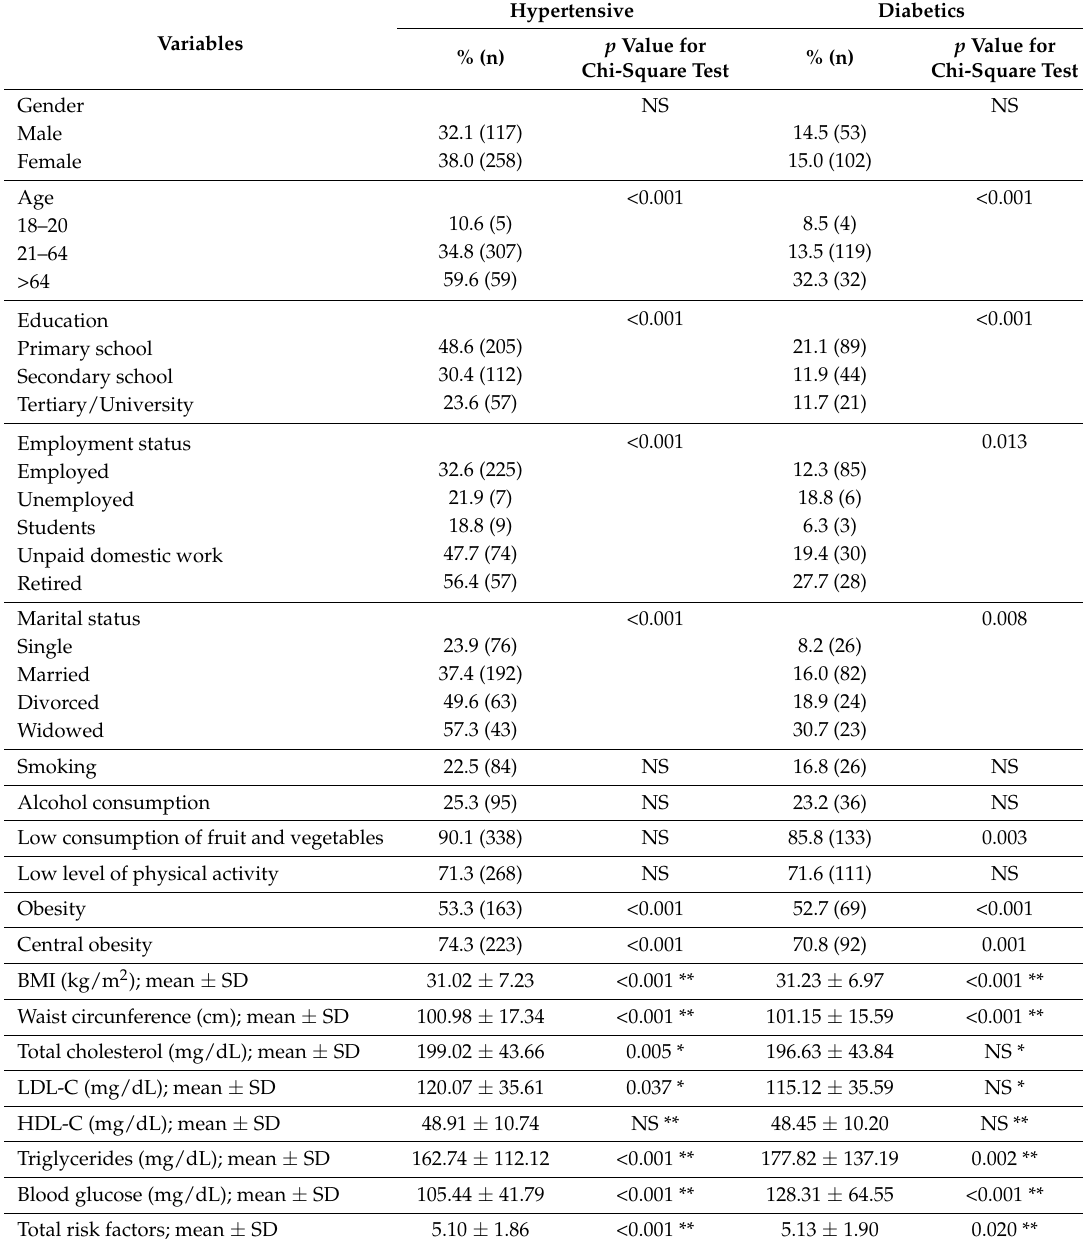
Table 4. Sociodemographics, lifestyle, anthropometry and blood biochemical profile of patients with hypertension and diabetes. Hypertensive Variables